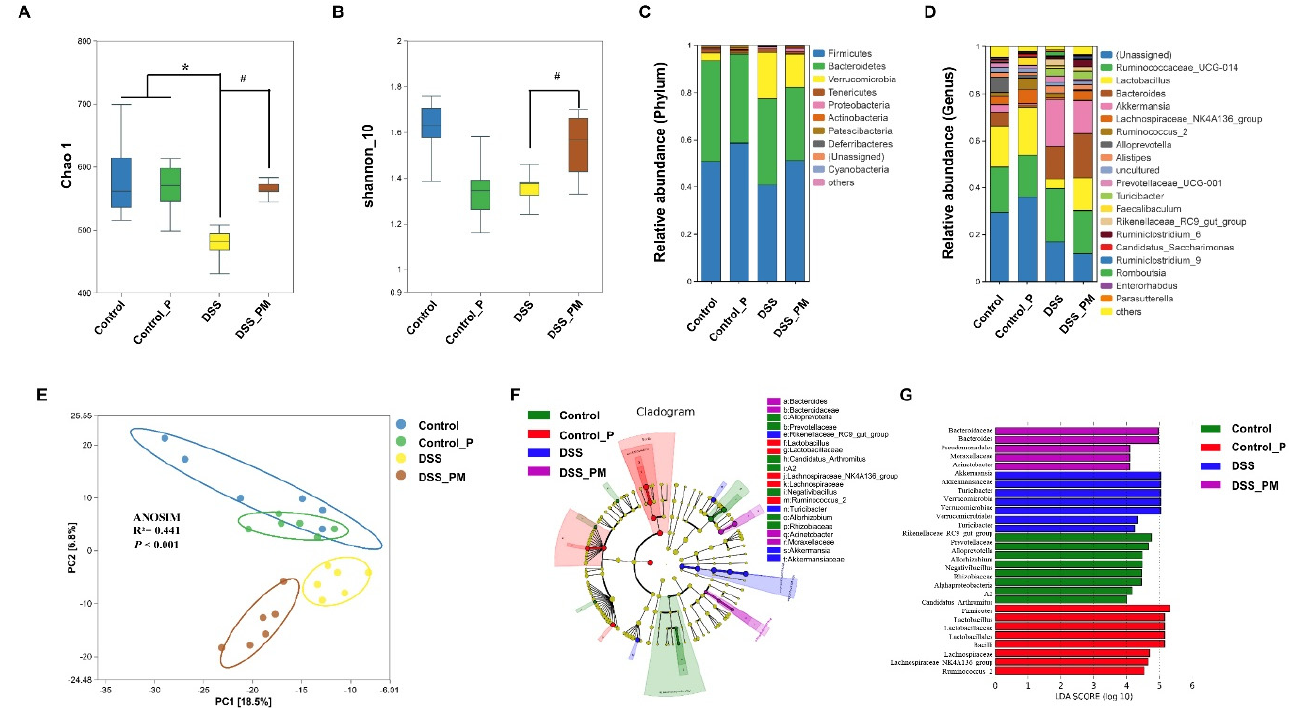
Figure 5. Pea albumin alleviated DSS-induced gut microbiota dysbiosis and reshaped the gut mi- crobiota community. ( A ) Chao1 index. ( B ) Shannon_10 index. ( C ) Relative abundance of gut micro-